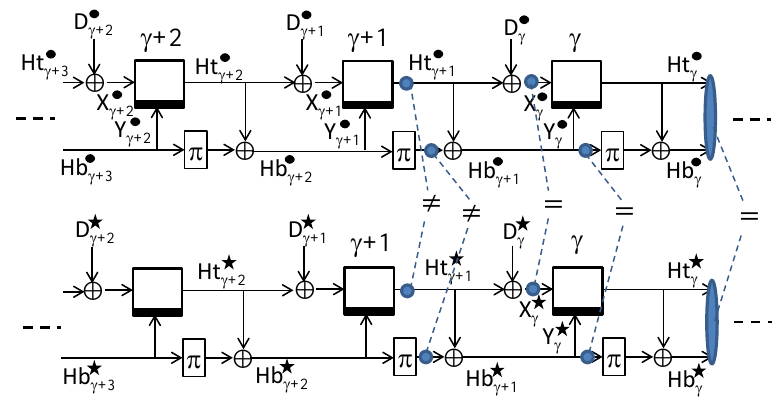
Figure 11: Hash procedures in Case 2, where tweaks for domain separation are